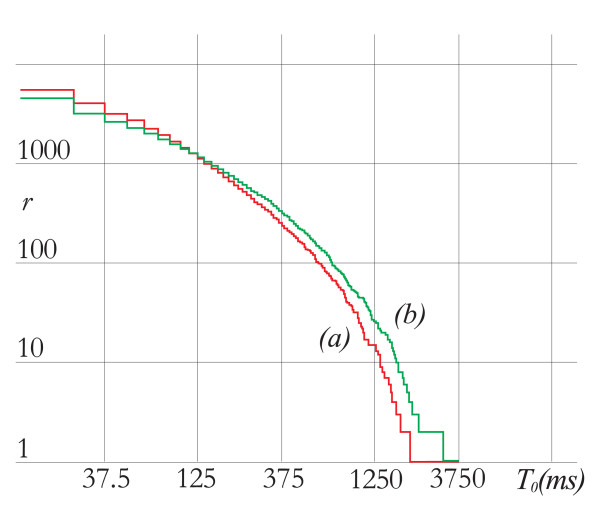
The number of low-variability periods N exceeding the length T0 for a significant subject: red line (a) – EEG signal with microwave (second sub-signal); green line (b) – EEG signal without microwave (first sub-signal).